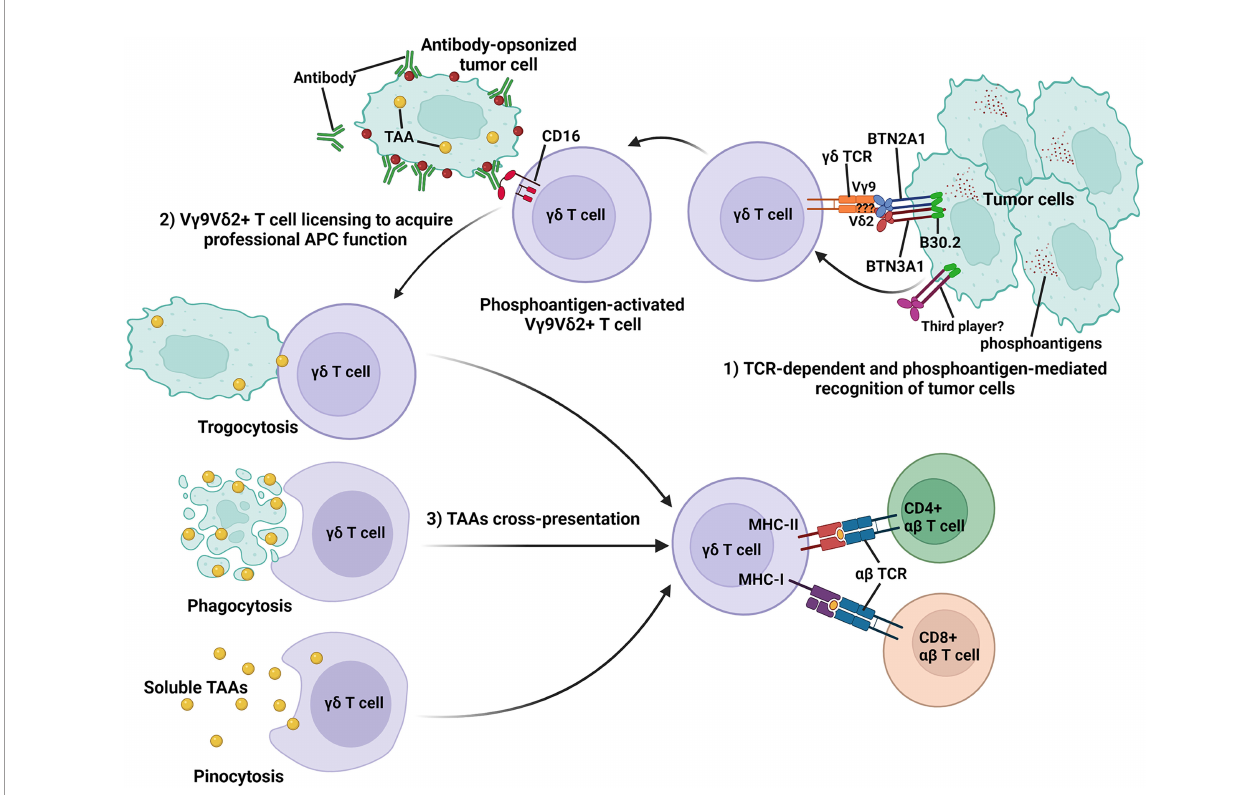
FIGURE 1 | Schematic representation of TCR-dependent and phosphoantigen-mediated recognition of tumor cells by V g 9V d 2 + T cells and the acquisition of professional APC function by activated V g 9V d 2 + T cells to cross-present TAAs to antigen-speci fi c CD4 + and CD8 + ab T cells. During the V g 9V d 2 + T-cell activation process, accumulated phosphoantigens in tumor cells bind to the intracellular B30.2 domain of BTN3A1. Following phosphoantigen binding, BTN3A1 undergoes conformational changes and induces the interaction between the intracellular domains of BTN2A1 and BTN3A1. BTN2A1 directly binds the TCR V g 9 chain and leads to T-cell activation in concert with at least one additional ligand. Activated V g 9V d 2 + T cells can recognize antibody-opsonized tumor cell via CD16 (Fc g RIII) and are licensed to acquire professional APC function via trogocytosis, phagocytosis, and pinocytosis and cross-present antigens from tumor cells to antigen-speci fi c CD4 + and CD8 + ab T